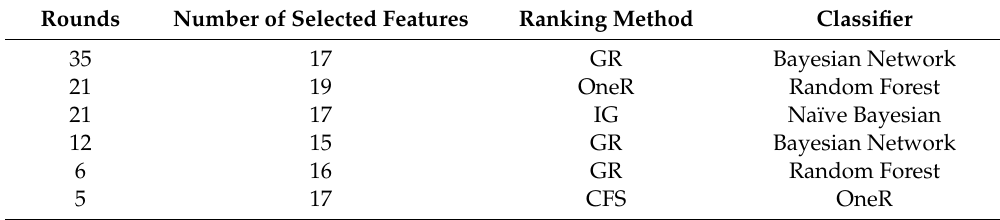
Table 4. Compositional classification results of all